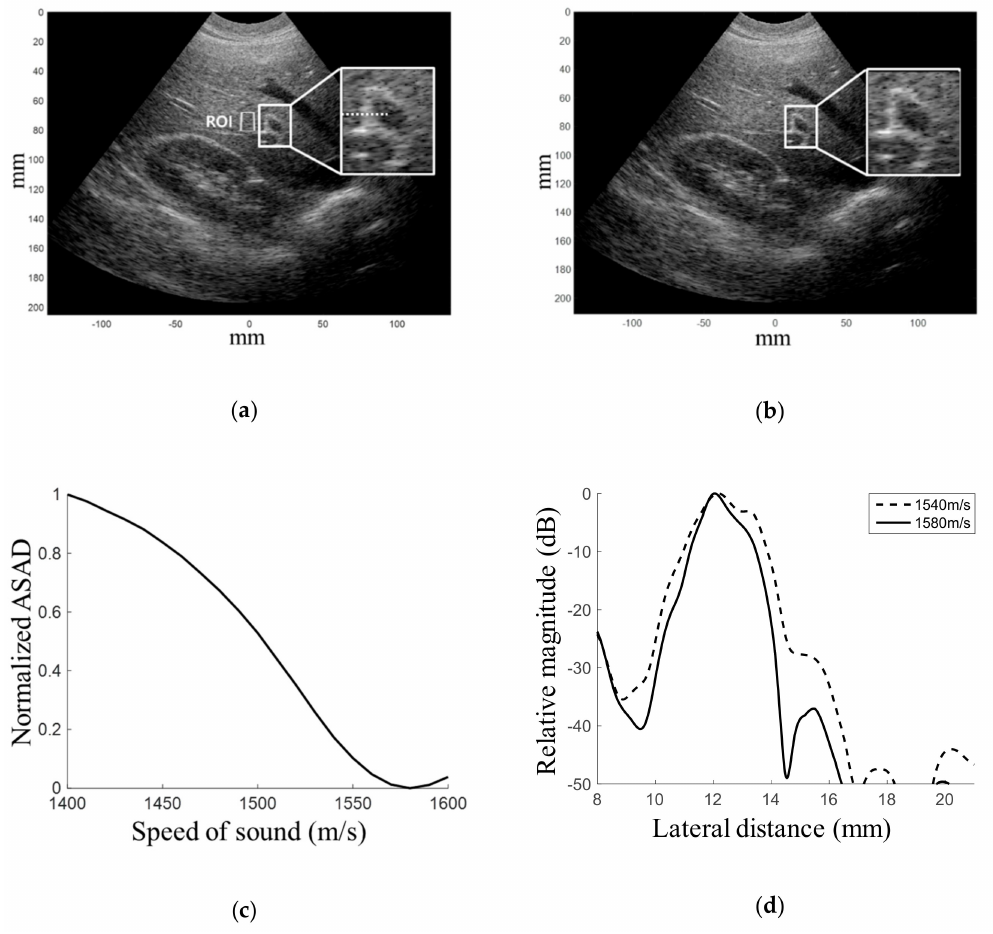
Figure 4. In vivo experiment results for the liver. B-mode image with sound speeds of ( a ) 1540 m / s and ( b ) 1580m / s, and ( c , d ) normalized ASAD values for the ROI. Cross-section of the vessel wall indicated by a dotted line in Figure